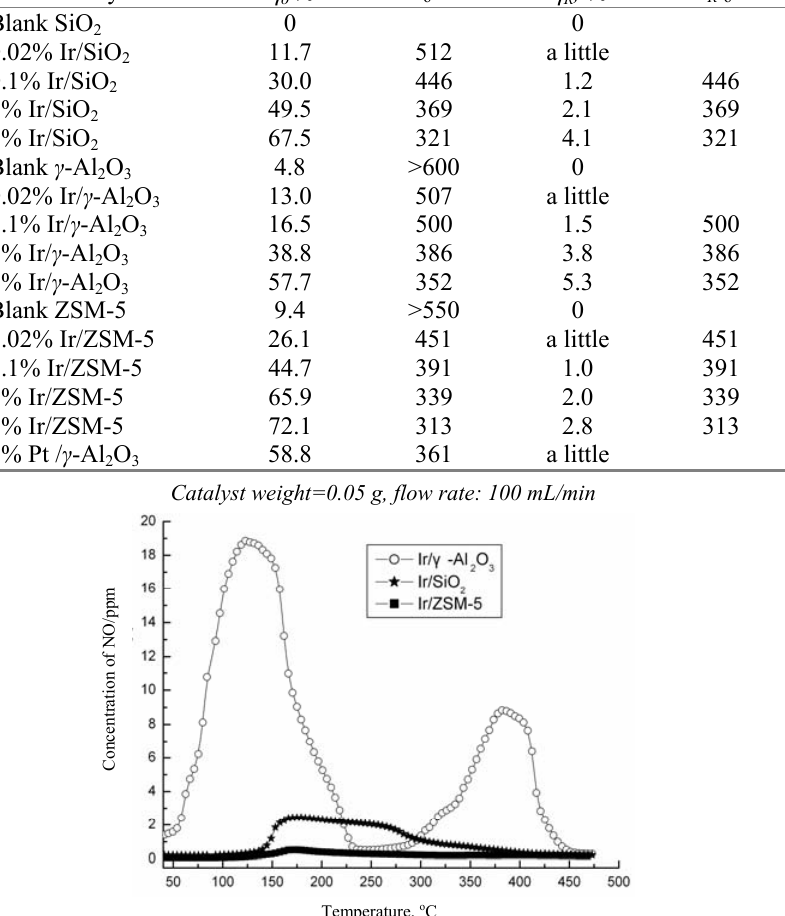
over Ir/ZSM-5, Ir/SiO 2